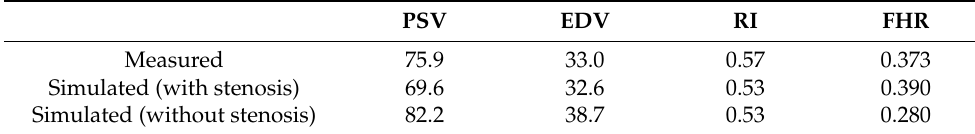
Table 2. Hemodynamic indices of a patient.